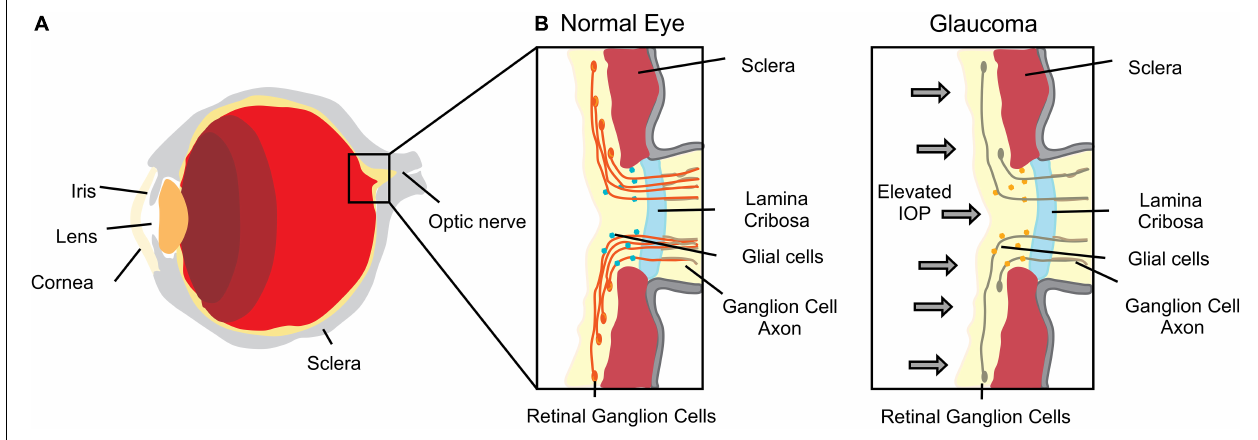
FIGURE 1 | Scheme of an eye. (A) Major anatomical structure and organization. (B) Enlarged section of the lamina cribrosa and optic nerve representation of tissue deformation in response to increased intraocular pressure (IOP) representative of glaucomatous optic neuropathy.